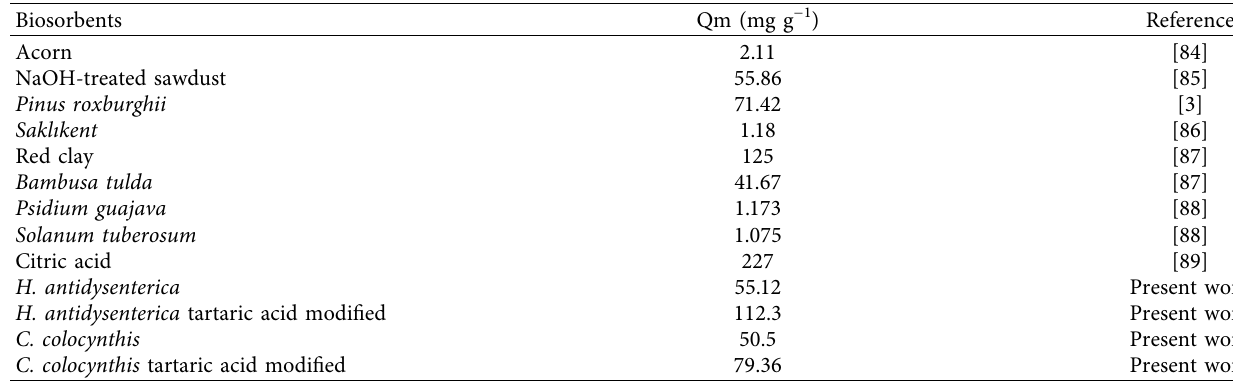
Table 4: Comparison between present and previous adsorbents for BG